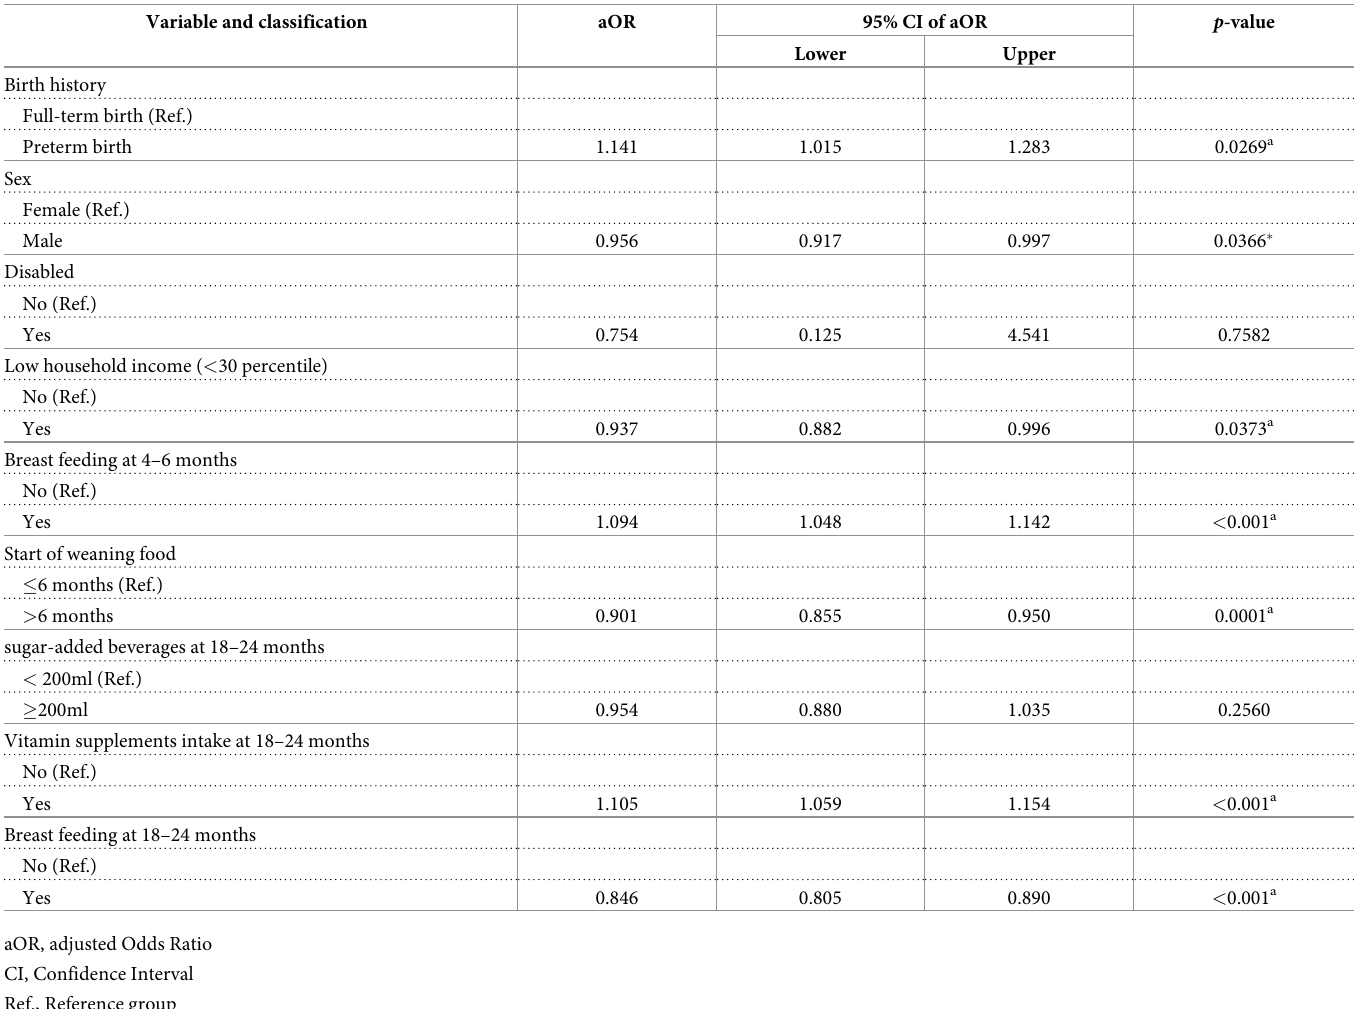
Table 6. Multivariable logistic regression analysis for oral health screening completion. Variable and